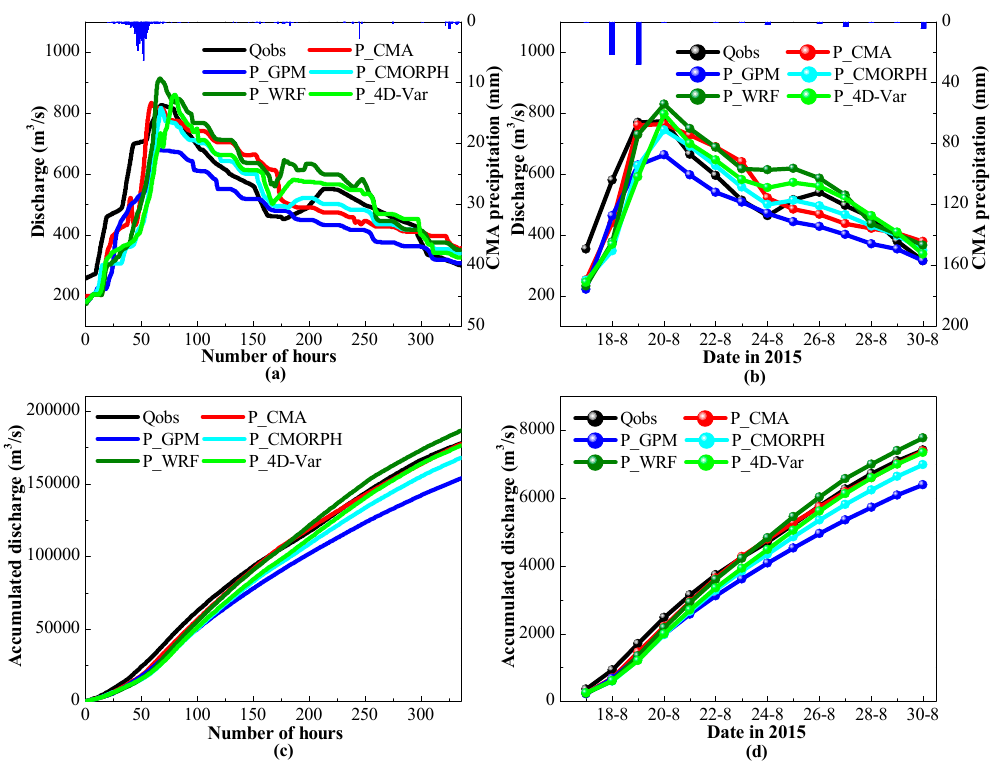
Figure 9. The results of the simulated hourly discharges ( a ), daily discharges ( b ), accumulated hourly discharges ( c ) and accumulated daily discharges ( d ) at the WJB watershed outlet.